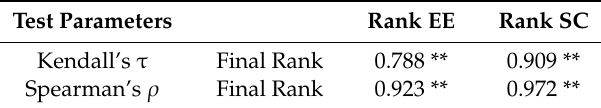
Table 18. Consistency test